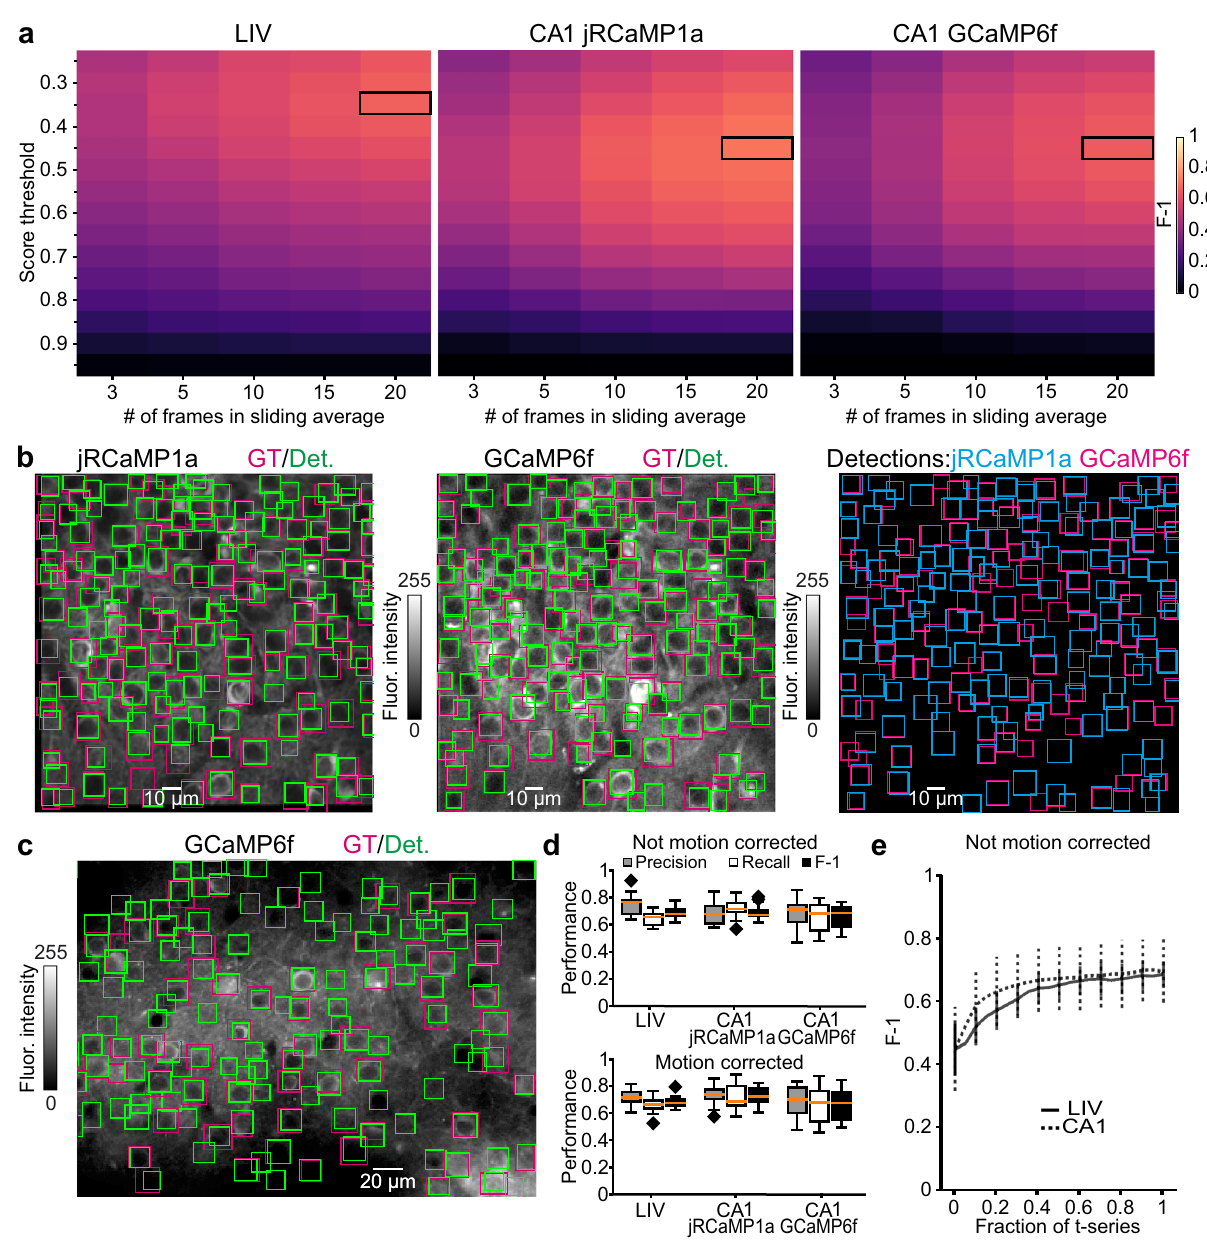
Fig. 3 CITE-On online cell detection performance. a Best parameter search for frame downsampling: F-1 score (pseudocolor) as a function of score threshold (vertical axis) and number of frames in the sliding average (horizontal axis) for LIV (left), CA1 jRCaMP1a (middle), and CA1 GCaMP6f (right). The maximal F-1 is indicated with the black rectangle. b Fluorescence median projections of one representative FOV for CA1 jRCaMP1a (left) and one FOV for CA1 GCaMP6f (middle). GT (magenta) and online detections at the end of the t-series (Det, green) are also shown. In the rightmost panel, the online detections of jRCaMP1a (cyan) and GCaMP6f (magenta) at the end of the t-series are shown. c Same as in b but for a representative LIV t-series. d Top: boxplots showing online performance as Precision (gray), Recall (white), and F-1 (black) for all t-series in the validation datasets (LIV, N = 13; CA1 jRCaMP1a, N = 12; CA1 GCaMP6f, N = 12). No motion correction was performed. Bottom: same as top, but for the motion-corrected t-series. The orange line in all boxplots (in top and bottom panels) is the median, the bounds of the boxes are the 75th and 25th percentiles (i.e., the interquartile range (IQR)), and the whiskers correspond to the highest value or lowest value of the distribution. If the lowest or highest values are outliers (i.e., >1.5 *IQR from the bounds of the boxes), the whiskers correspond to 1.5 *IQR. Outliers are represented as black diamonds. Results of Kolmogorov – Smirnov test for performance in not motion-corrected t-series vs. motion-corrected t-series from LIV: p = 0.54 for F-1, p = 0.15 for Precision, p = 0.38 for Recall, N = 13 t-series. Results of two-sided Kolmogorov – Smirnov test for performance in not motion-corrected t-series vs. motion-corrected t-series from CA1 jRCaMP1a: p = 0.16 for F-1, p = 0.20 for Precision, p = 0.20 for Recall, N = 12 t-series. Results of Kolmogorov – Smirnov test for performance in not motion corrected vs. motion-corrected t-series from CA1 GCaMP6f: p = 0.18 for F-1, p = 0.28 for Precision, p = 0.22 for Recall, N = 12 t-series. e F-1 values as a function of the fraction of the total length of the t-series for not-motion corrected data ( N = 13 t-series for LIV, N = 24 t-series for CA1, including N = 12 t-series for CA1 jRCaMP1a and N = 12 t-series for CA1 GCaMP6f